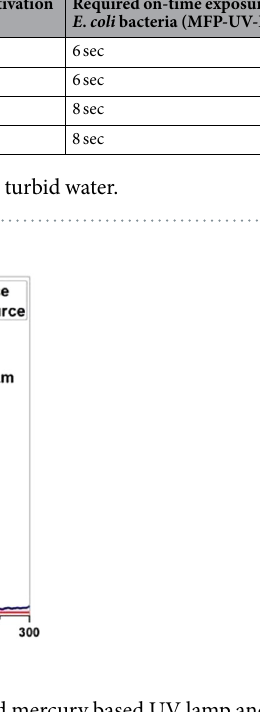
Figure 7. Comparison of UV-C spectra of a standard mercury based UV lamp and MFP-UV